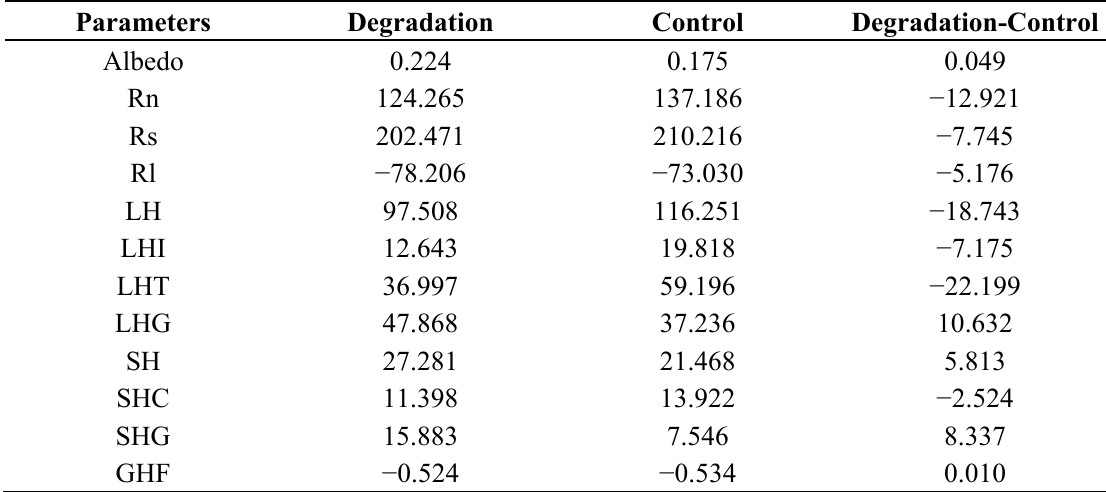
Table 3. Simulated ensemble JJA mean of energy-balance components for degradation